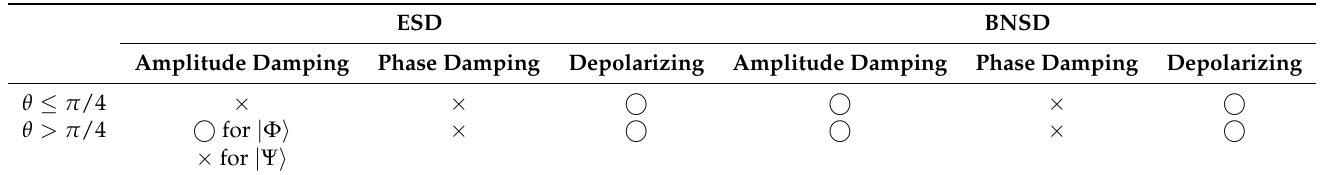
Table 2. Entanglement sudden death (ESD), and Bell nonlocality sudden death (BNSD) for three types of decoherence channel. (cid:13) represents ESD and BNSD occur, and × represents ESD and BNSD do not